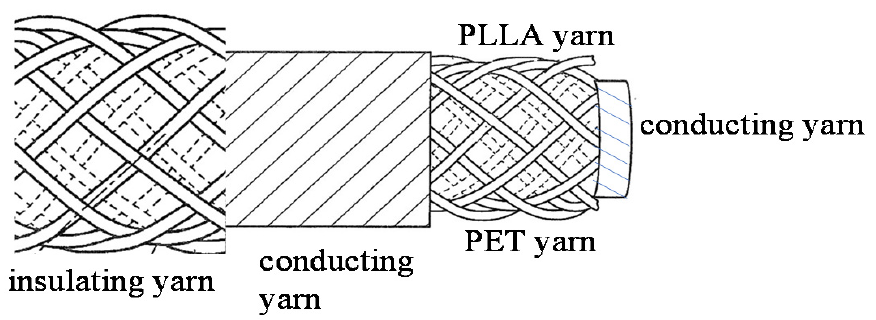
Figure 3. Piezoelectric PLLA braided cord. cyclical forces